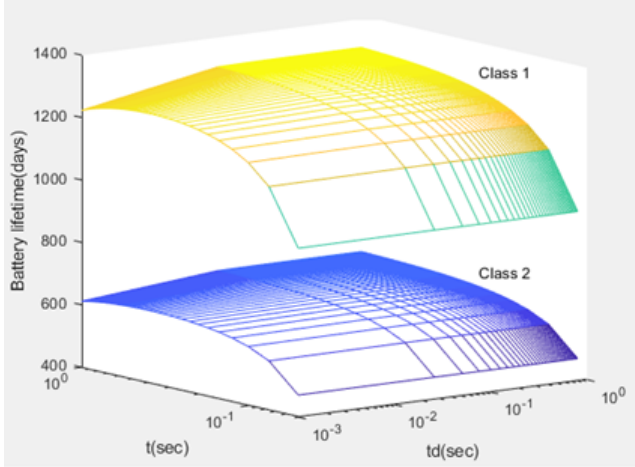
Figure 20. The lifetime of a device’s battery L j versus t and td .